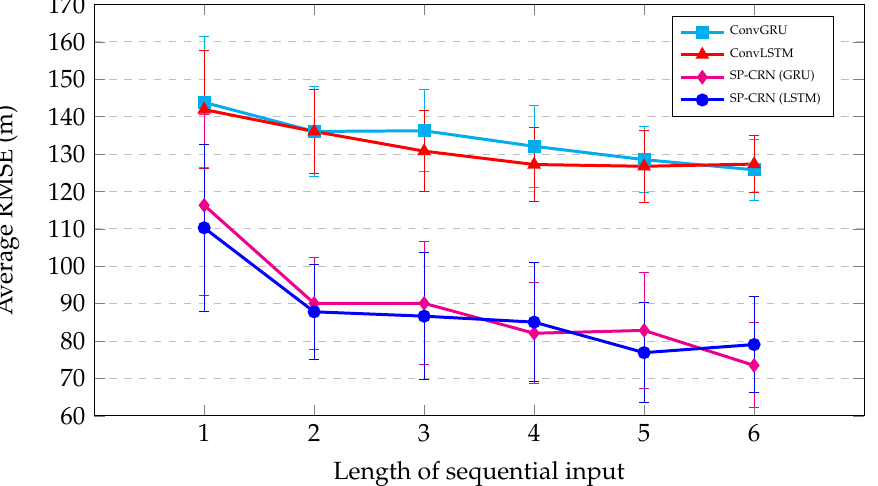
Figure 5. The average RMSE of the comparison methods in different length of sequential input for ZH300 prediction. The error bar indicates the SD of the